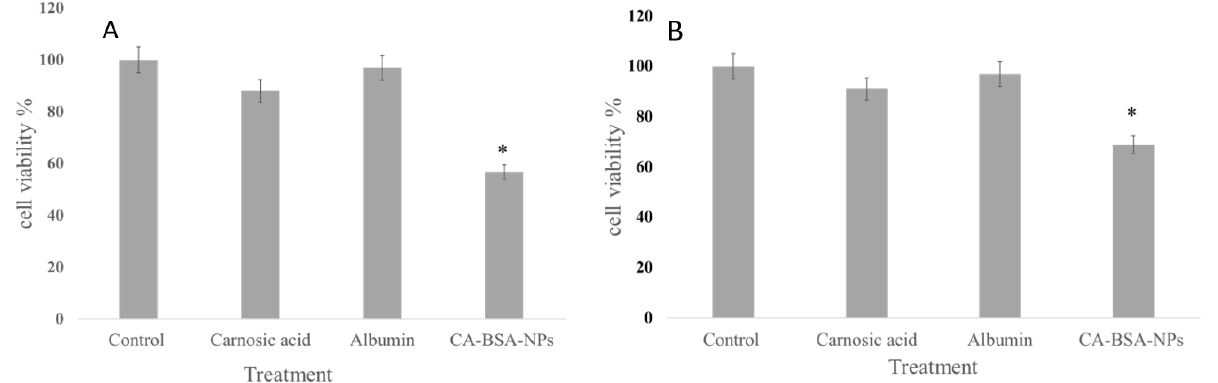
Figure 6. ( A ) Cell viability of Caco-2 cell line after treatment with carnosic acid, albumin and CA- BSA-NPs.( B ). Cell viability of MCF-7 after treatment with carnosic acid, albumin and CA-BSA-NPs. * means significant difference p < 0.05.